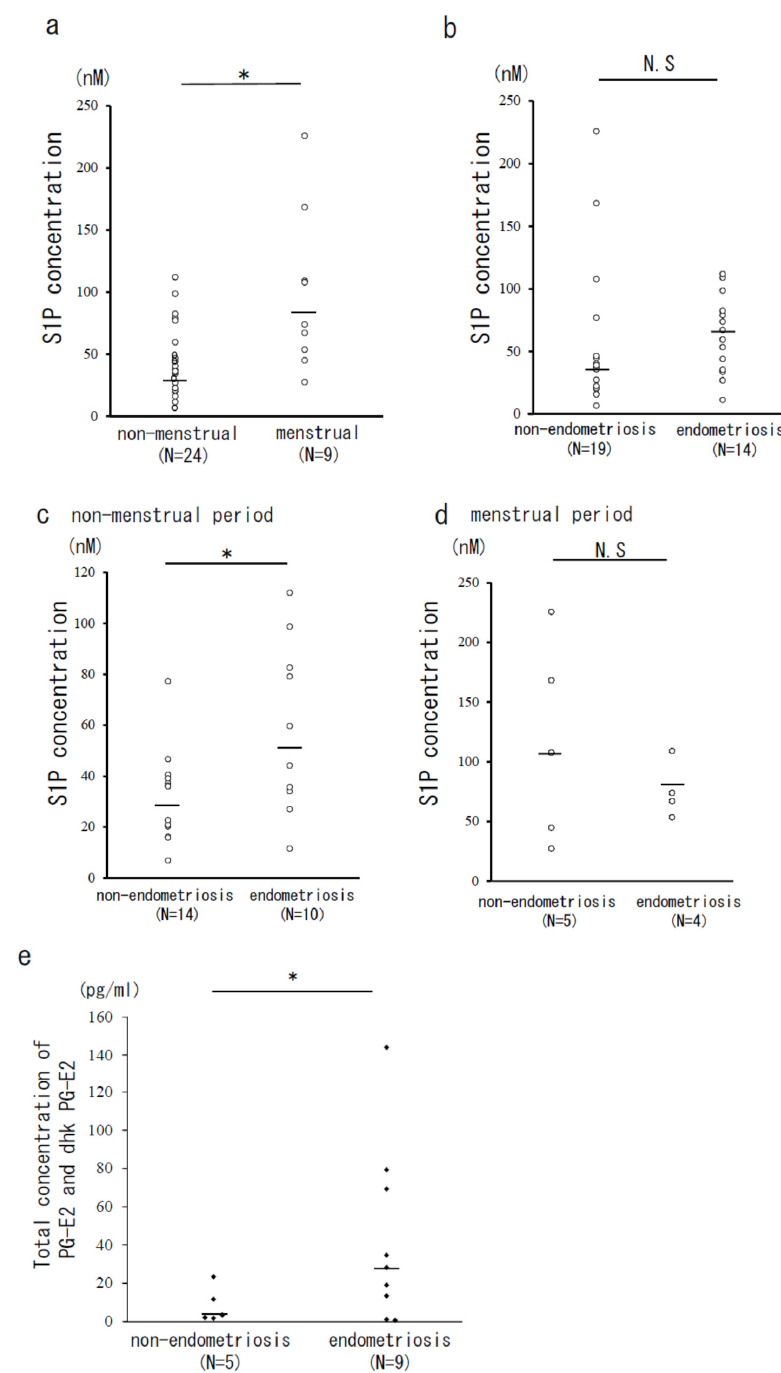
Figure 1. The concentration of S1P and prostaglandin (PG)-E2 with its metabolites (dhk PG-E2) in peritoneal fluid measured by mass spectrometry. The peritoneal S1P levels were compared between the patients during the non-menstrual period ( N = 24) and the menstrual period ( N = 9) ( a ), and between the non-endometriosis ( N = 19) and endometriosis patients ( N = 14) ( b ). The S1P levels in the non-menstrual ( N = 14 vs. N = 10, ( c ) and the menstrual periods ( N = 5 vs. N = 4, ( d ) of non-endometriosis and endometriosis patients were compared. The concentration of PG-E2 and its metabolites (dhk PG-E2) was compared between the non-endometriosis ( N = 5) and endometriosis patients ( N = 9) ( e ). Bars show the median value. *, p < 0.05; N.S., not